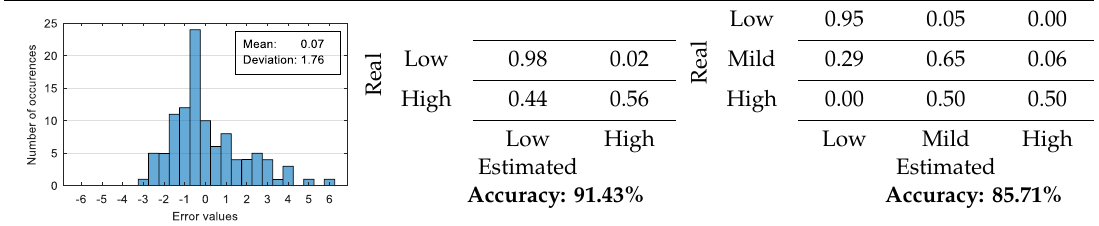
Table 8. Distribution of estimation errors and confusion matrices for levels 2 and 3—using three features.